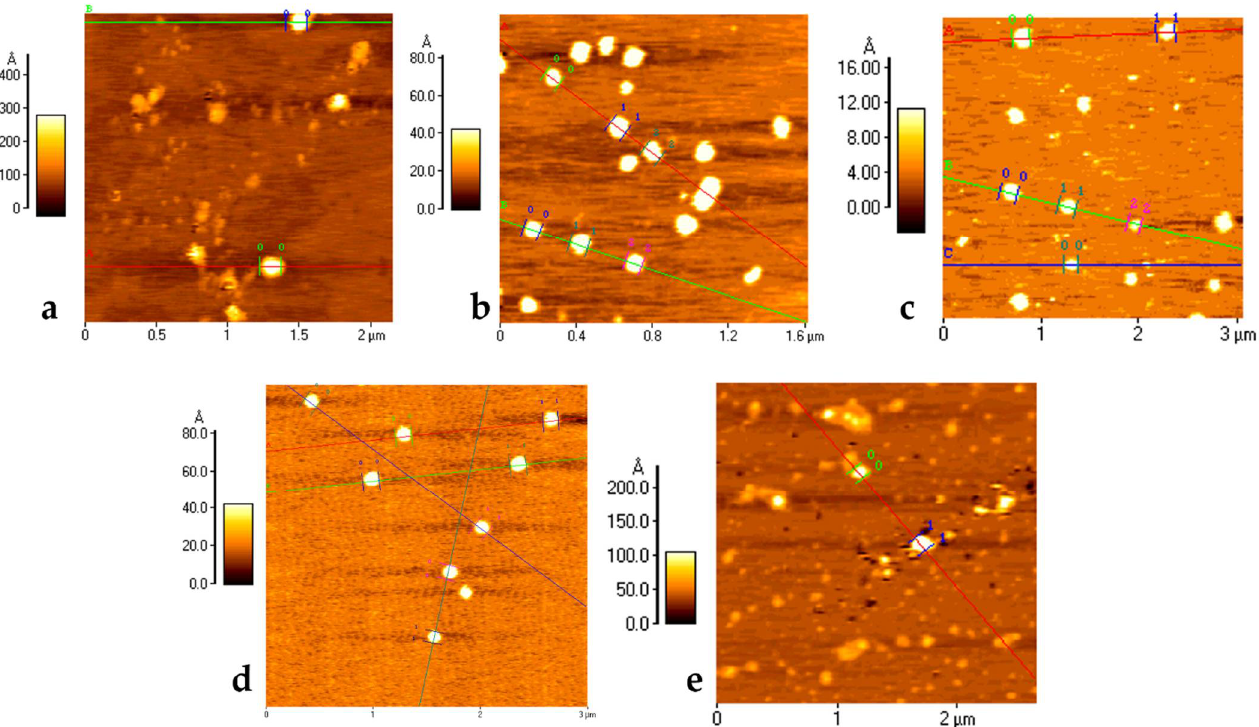
Figure 1. AFM Microscopy analysis of NMeds: ( a ) non-modified NMeds; ( b ) g7-NMeds; ( c ) PAAVF-NMeds; ( d ) M08J-NMeds; and ( e ) M08-NMeds. All images were obtained with NMeds modified with 10 μg of ligand. Coloured lines are added during post acquisition processing of images to analyse the size and height profile of NMeds, with numbered markers for each NMed.